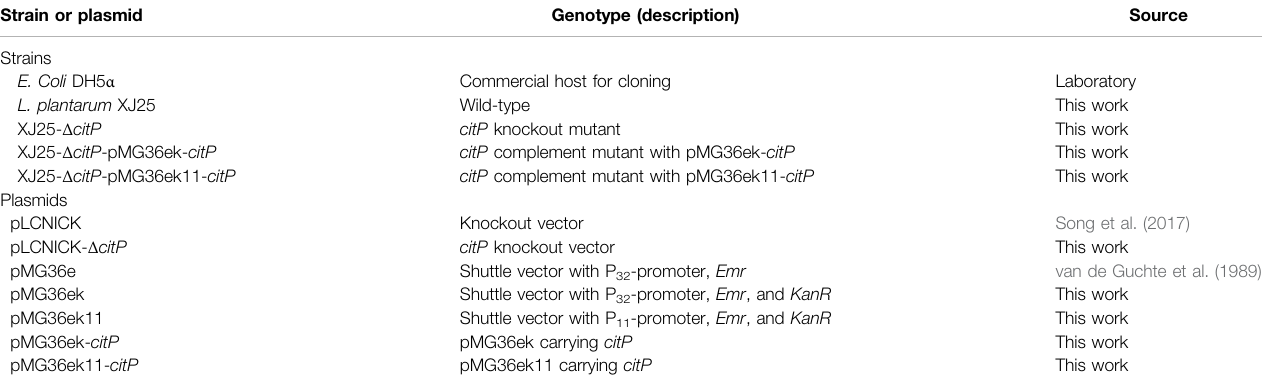
TABLE 1 | Bacterial strains and plasmid vectors used in this study. Strain or plasmid